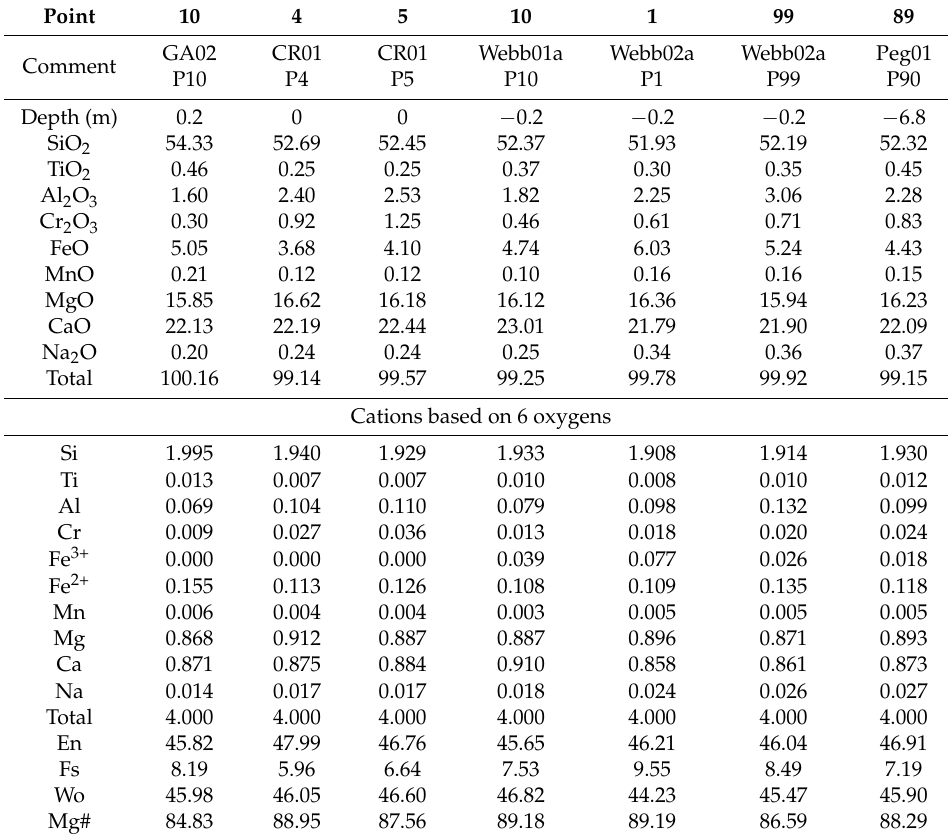
Table 4. Representative clinopyroxene analyses in wt %.